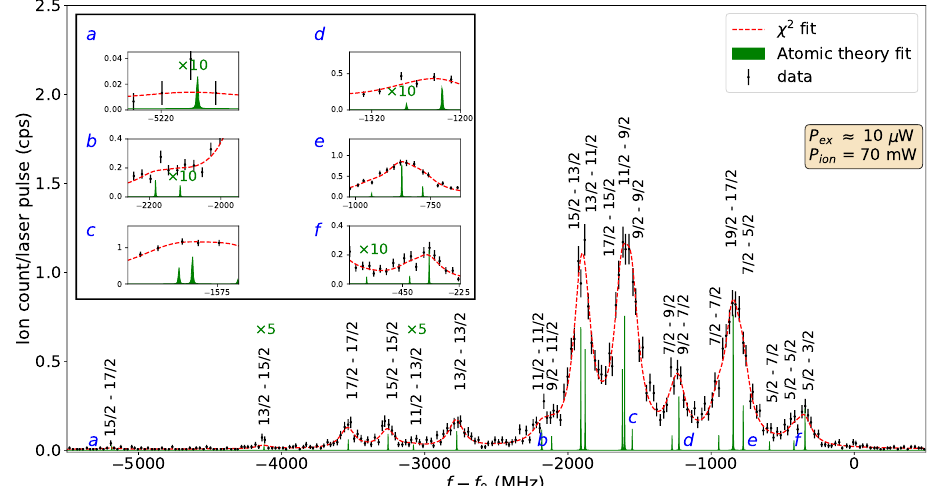
Figure 10. Normalized single HFS measurement of 167 Er I with an inset in the top left corner containing details of the least intense/clearly resolved HFS components a − f (red/green curve— SATLAS [35] χ 2 data fit/atomic resonance positions based on input parameters; the weakest peaks according to atomic theory have been magnified for visualization purpose and are presented in the insets, with a multiplication factor added to the HFS component; f 0 = 721.9966 THz; text box presents the used excitation and ionization step powers P ex and P ion ; the used RIS scheme is presented in Figure